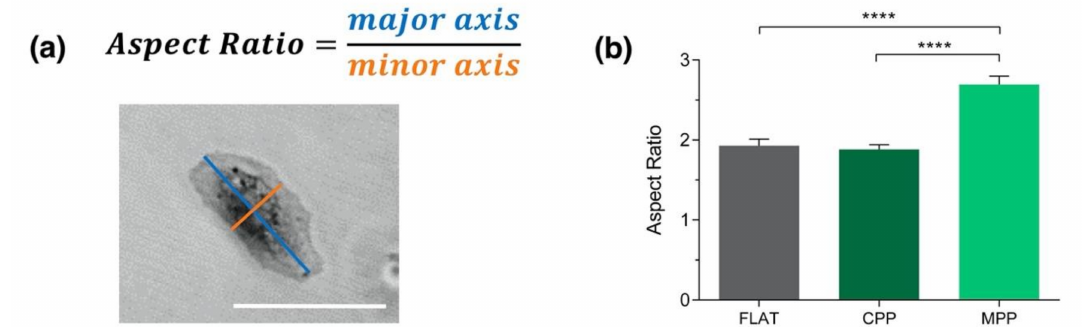
Figure 8. ( a ) Aspect ratio is defined as the ratio of the cellular major and minor axes. Scale bar 30 µ m. ( b ) Cell morphology analysis on flat substrates (FLAT) or patterned ones, using either the conventional (CPP) or the modified photoembossing protocol (MPP). Unpaired Student’s t -test **** p <